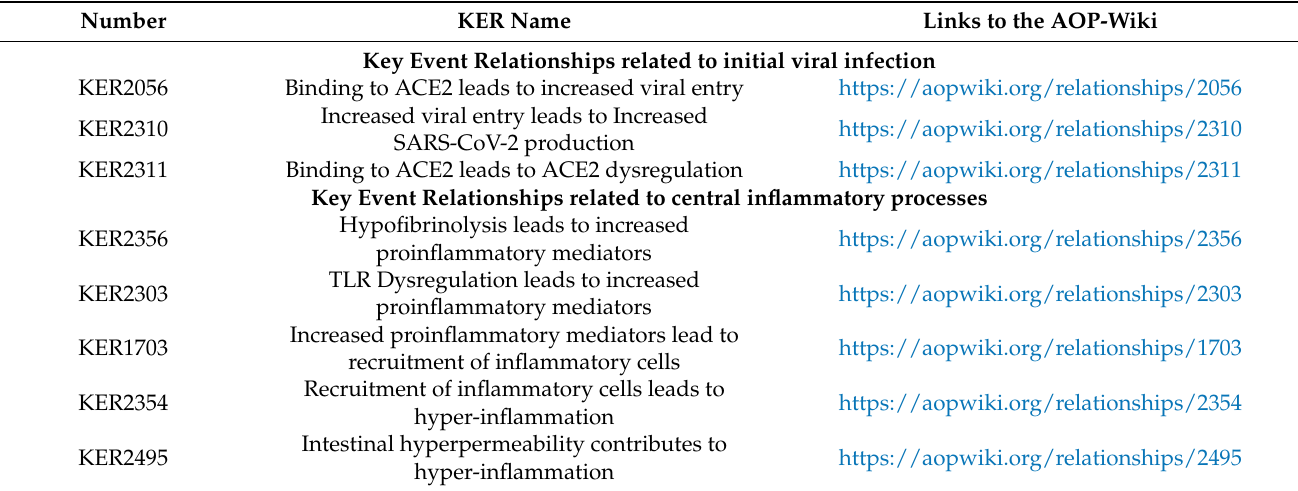
Table 2. KERs and KEs mentioned in the text by their numbers. AOP-Wiki represents the central repository for AOP-related knowledge. Each KE and KER has an assigned number as a unique identifier. The KE pages describe “Key Events”, a measurable change in a biological system. KER pages explore the scientific evidence for causality between two KEs (i.e., event A leads to Event B). All https://aopwiki.org links were accessed on 17 March